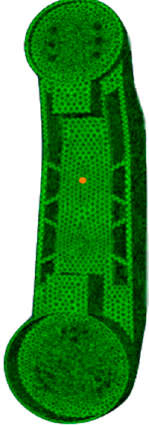
Figure 3. Overall mesh of the model.